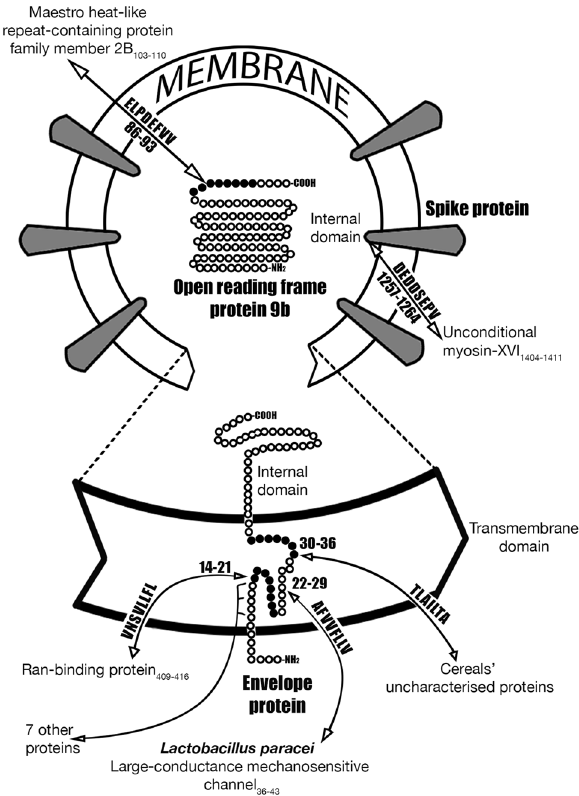
Figure 1. The SARS CoV-2 S, E and ORF9b protein molecules contain hepta/octamers that are homologous to proteins in the human body, including some nutrients and intestinal commensal bacteria.